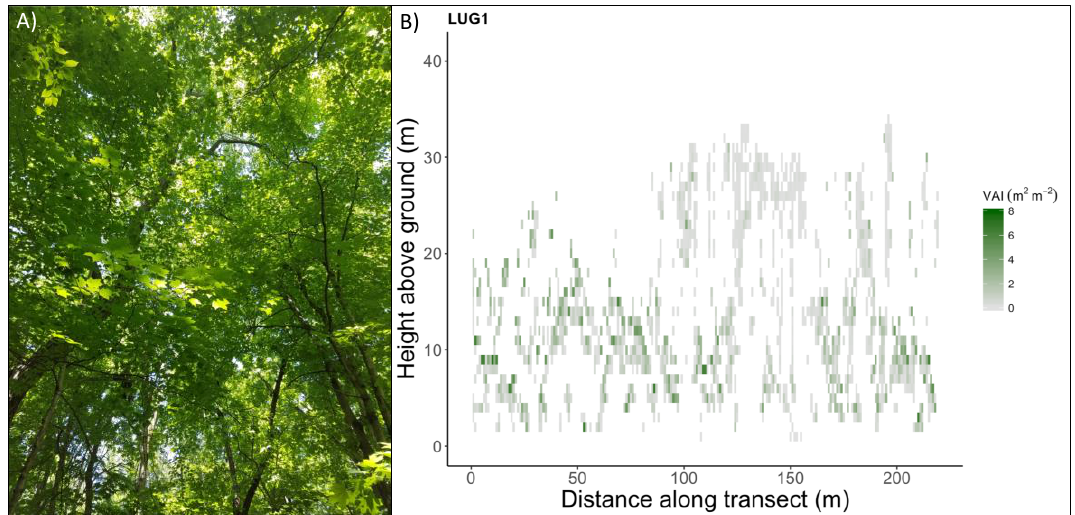
Figure 1. An example vertical cross section of a forest canopy collected from the portable canopy LiDAR. The transect was 250 m long and was collected within the Purdue University Lugar Farm Research Area, Indiana, USA. ( A ) An image of the canopy at 0 m on the transect. ( B ) Vegetation area index (VAI) was calculated using data collected along a 250 m transect with the portable canopy LiDAR unit. Each pixel in the cross section corresponds to a 1 m 2 bin containing values of VAI. The lighter to darker green shading corresponds to increasing values of VAI.